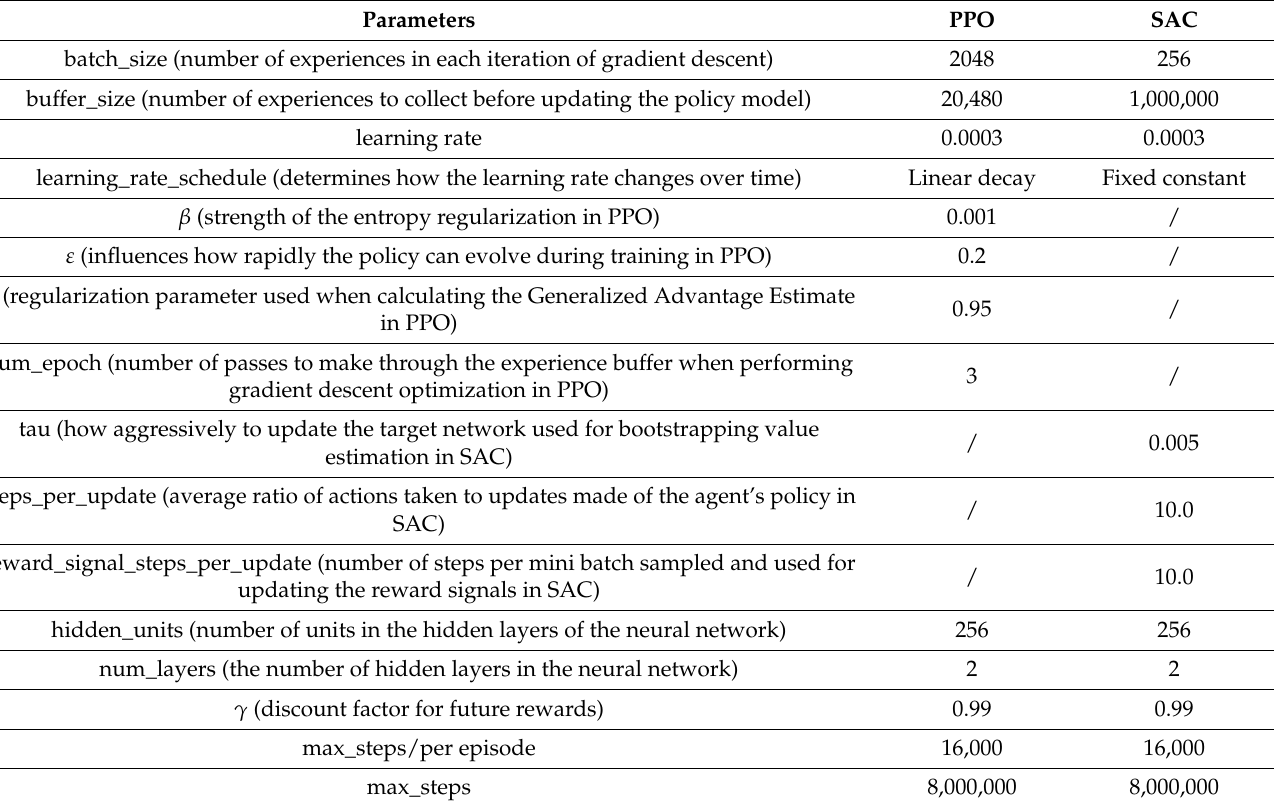
Table 7. Specific experimental parameters.